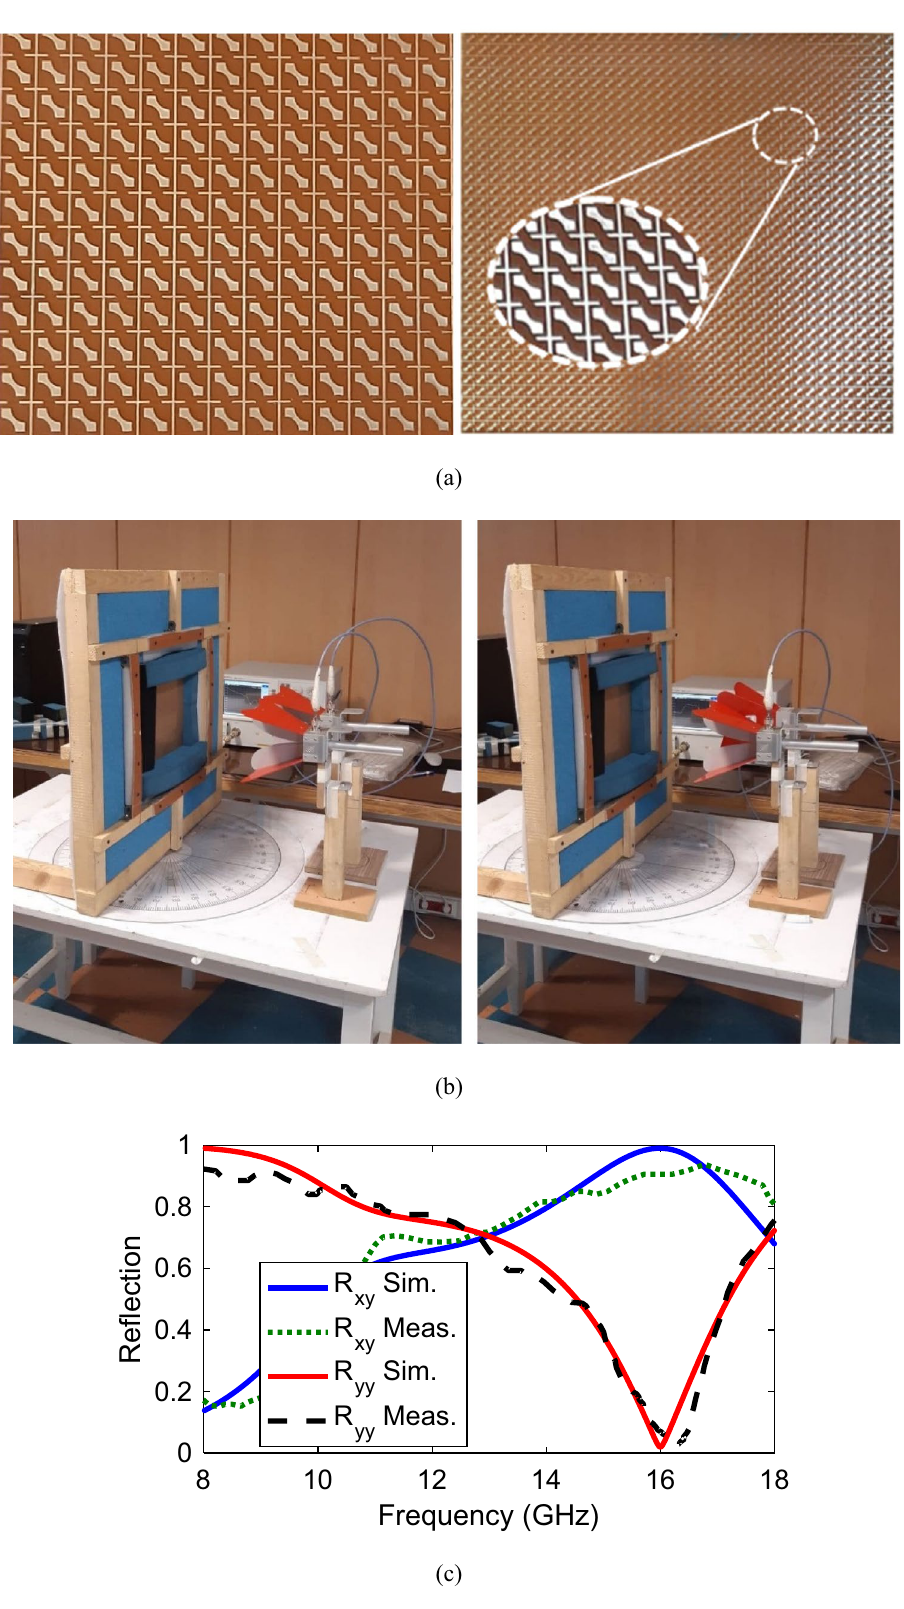
Figure 10. ( a ) Fabricated prototype with overall size of 204 × 204 mm 2 , ( b ) measurement setup for R yy and R xy , ( c ) Simulated and measured reflection